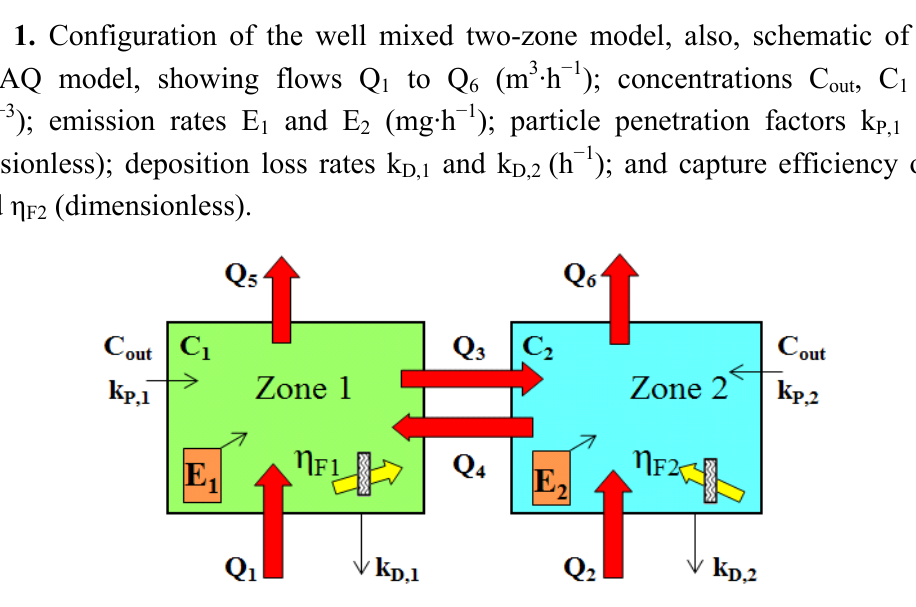
, C and C out 1 2 and k P,1 P,2